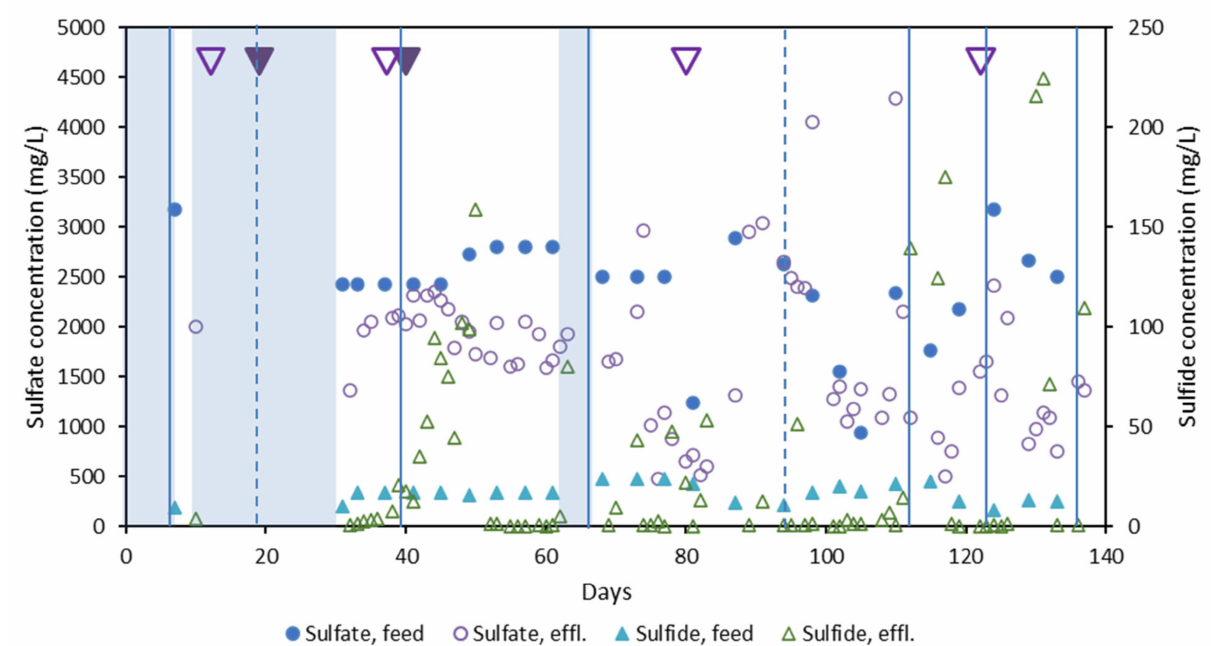
Figure 2. Change in the sulfide and sulfate concentrations over the HLFCR system adapted from [14]. Dashed and full vertical lines indicate biofilm harvest and disruption events, respectively, and shading indicates periods of batch operation. Effl. = effluent.